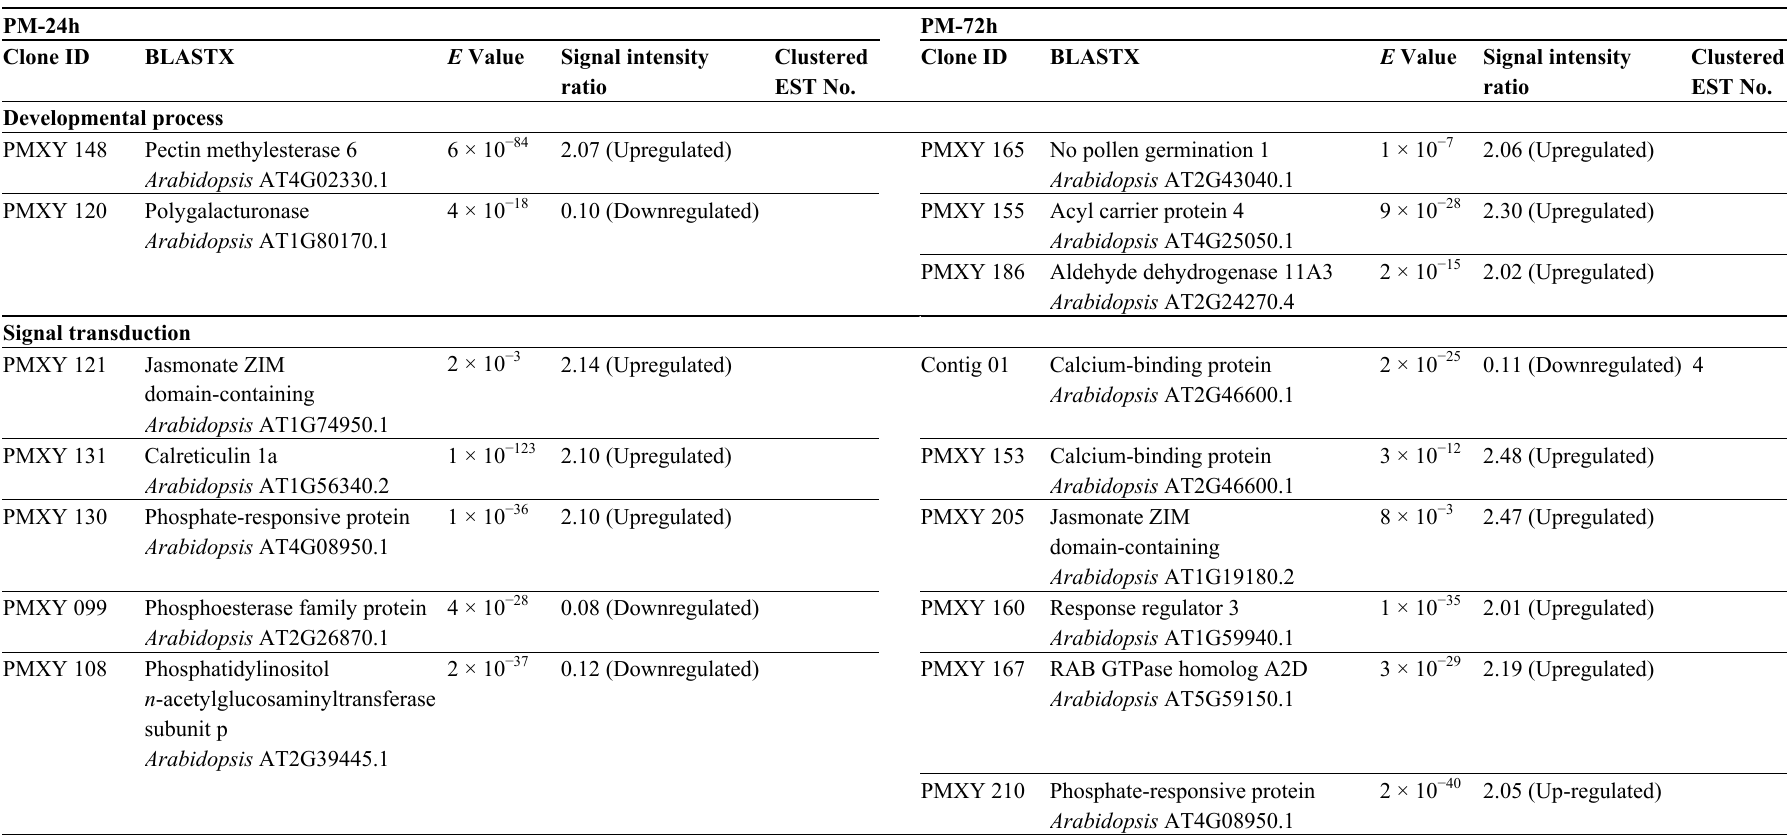
Table 2. Characterization of genes selected from subtractive suppression hybridization (SSH) libraries constructed with mRNA from PWN-inoculated Pinus massoniana stems sampled at 24 h and 72 h after PWN inoculation. The signal ratio indicates the normalized PWN-inoculation/water-inoculation